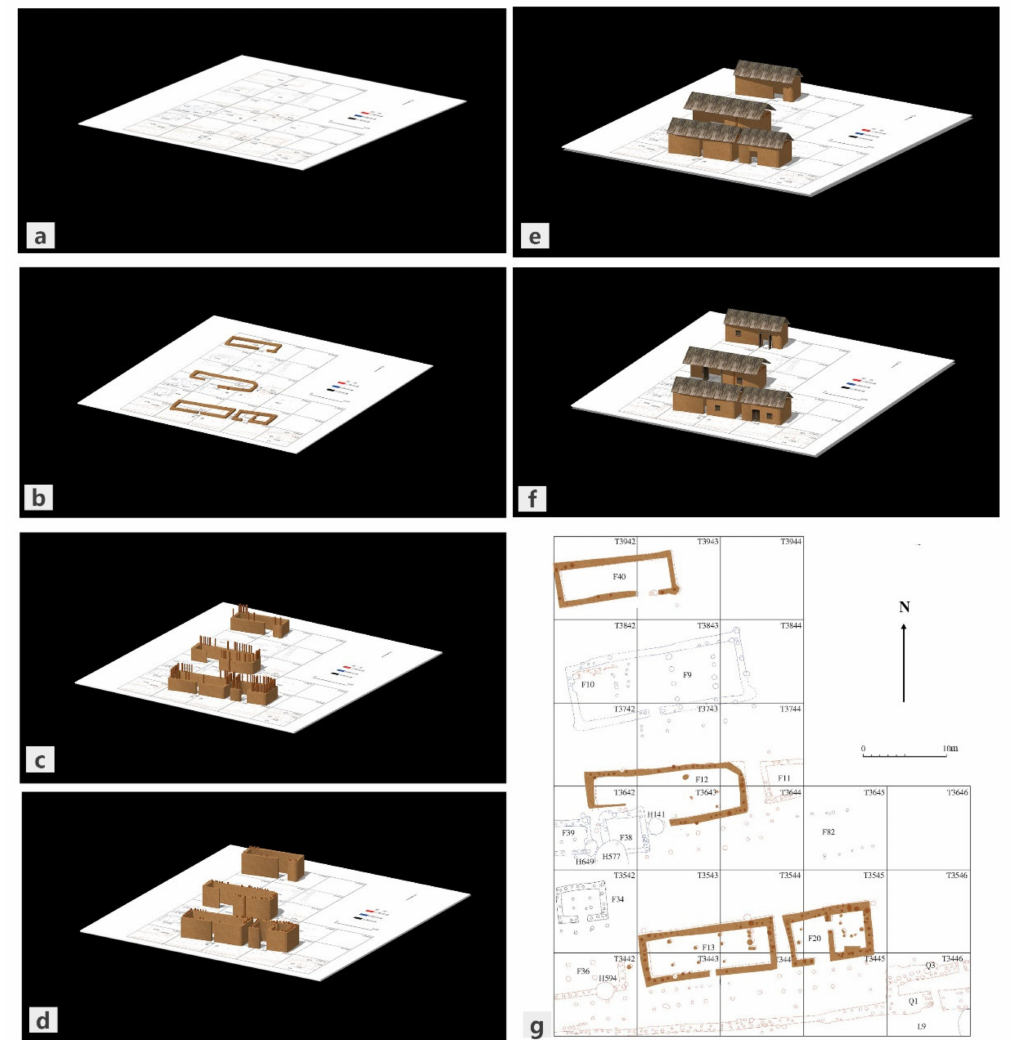
Figure 15. Model of the construction process of the house site at the SHS site (the survey and base map are described in reference [62]): ( a ) a mapping of the base of the house inside the site ( b – f ) The process of building a house site by the early pioneers, including the ramming of the foundation, the insertion of wooden posts, and the plastering of the walls; ( g ) the position and fall of part of the 3D model of the house